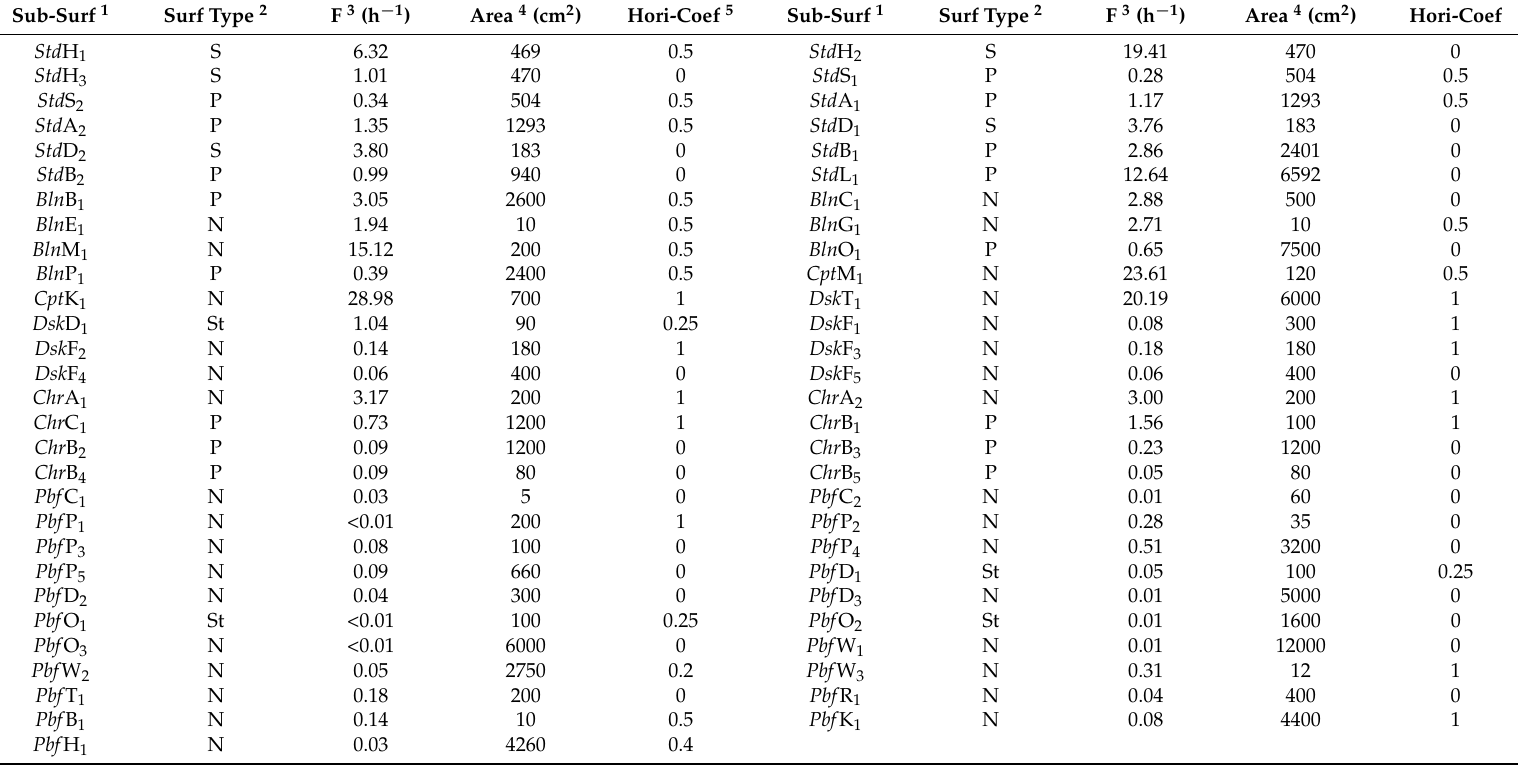
Table 3. Detailed information of all